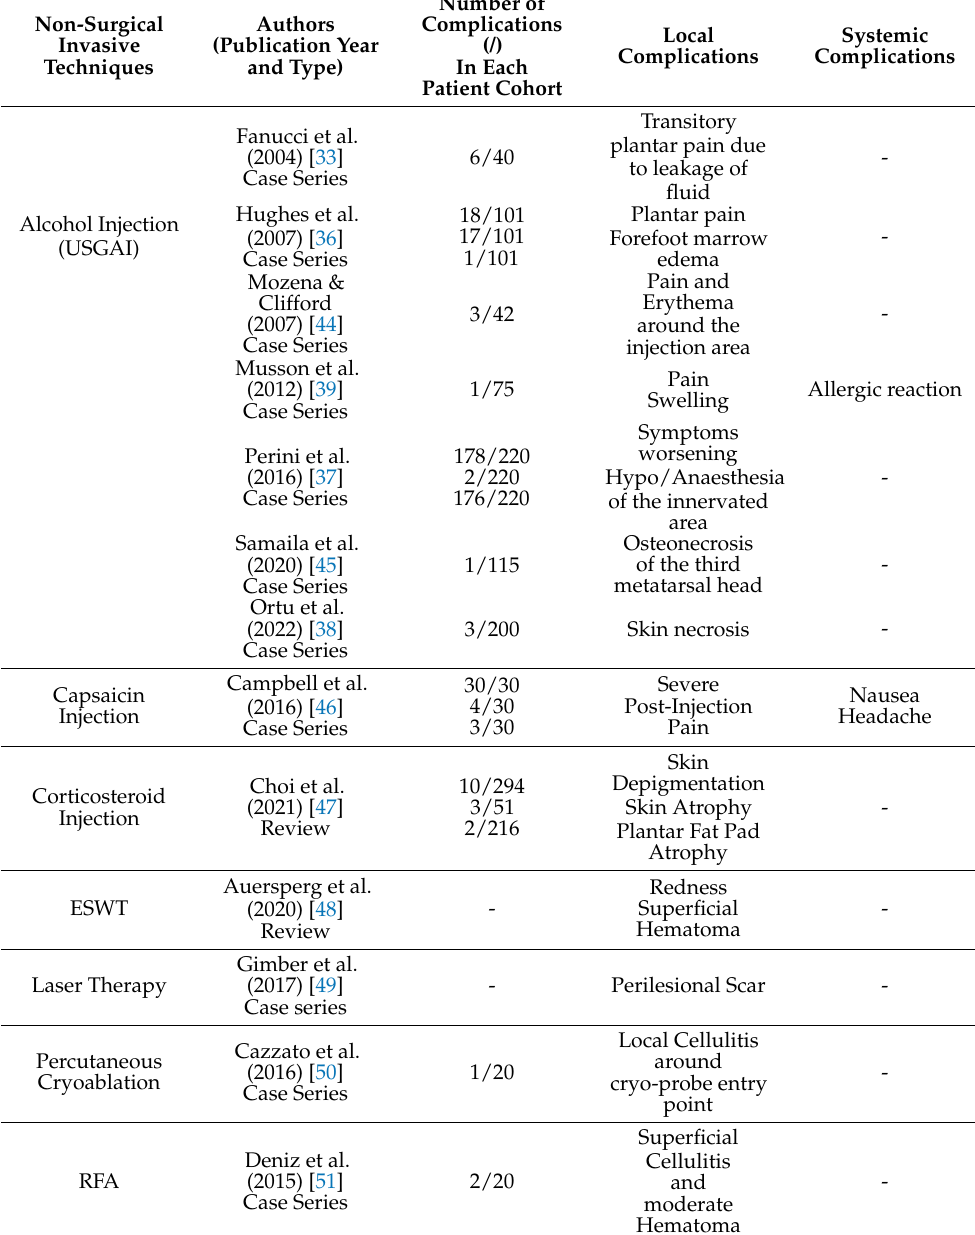
Table 1. Main complications of the non-surgical procedures described in the modern literature for Morton’s syndrome treatment (-: no